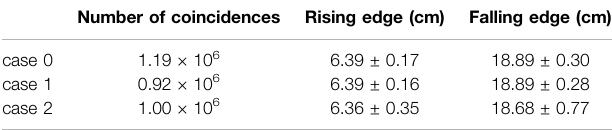
TABLE2| Risingandfallingedgede fi ningtheactivitypro fi ledistributionforeachof the considered PET geometries. Number of coincidences Rising edge (cm) Falling edge